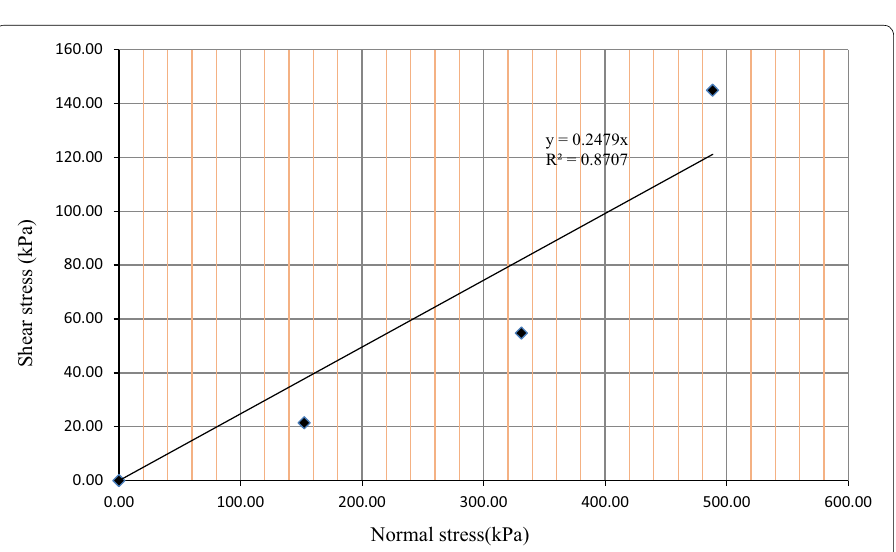
Fig. 5 Shear stress versus normal stress plot, soil to soil using peak normal stress method for sample